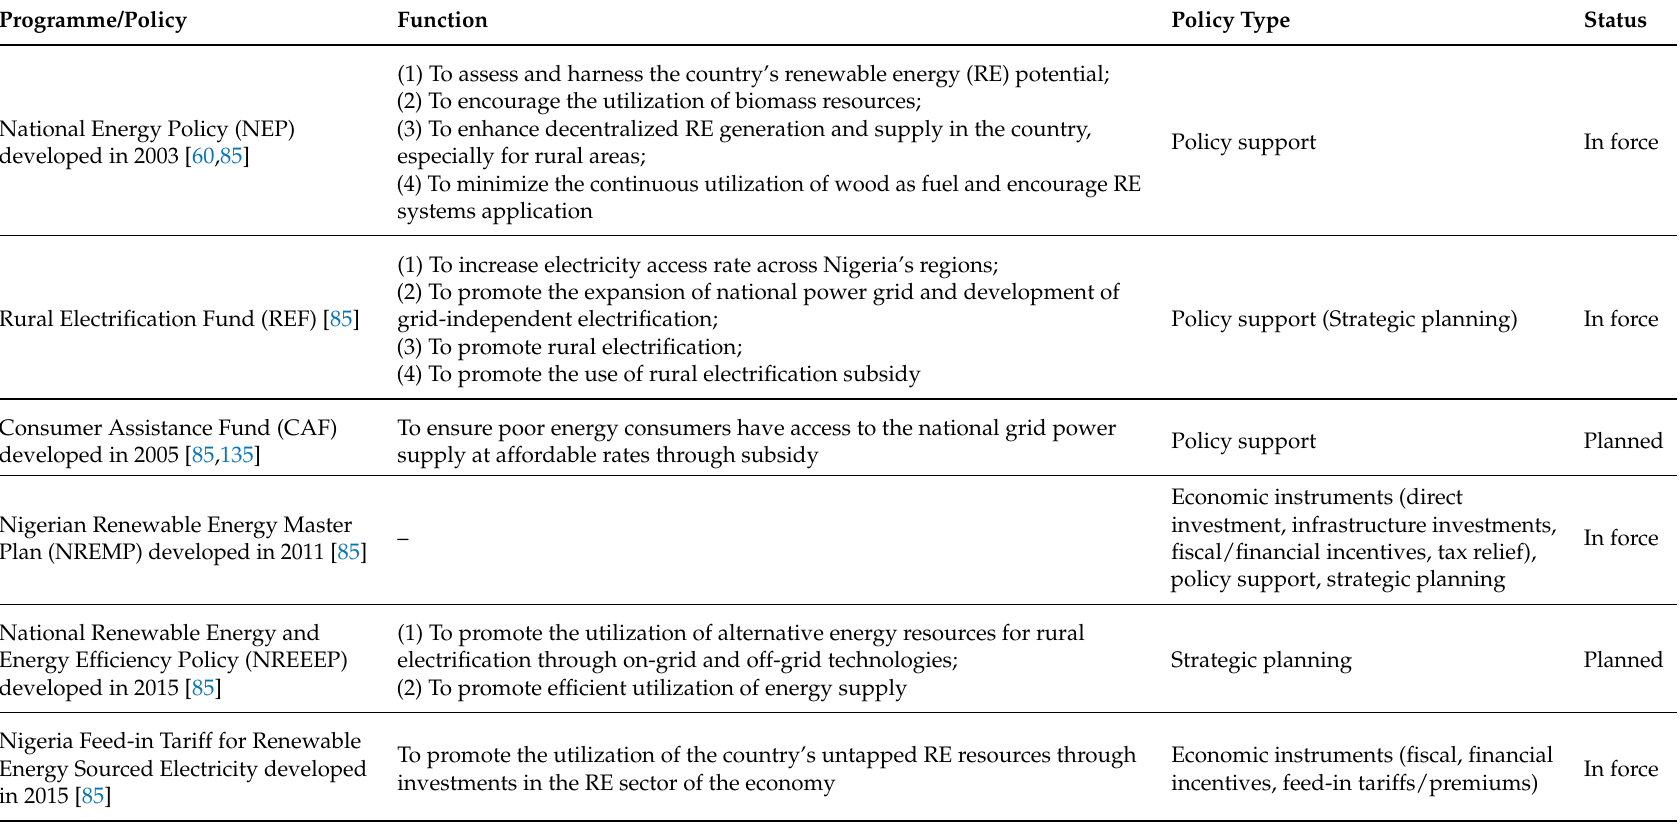
Table 4. Some of Nigeria’s energy